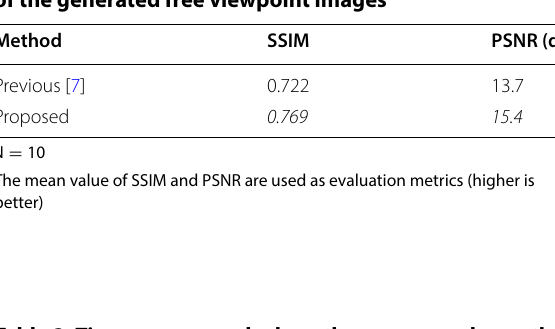
Table 2 Time consumed by the proposed